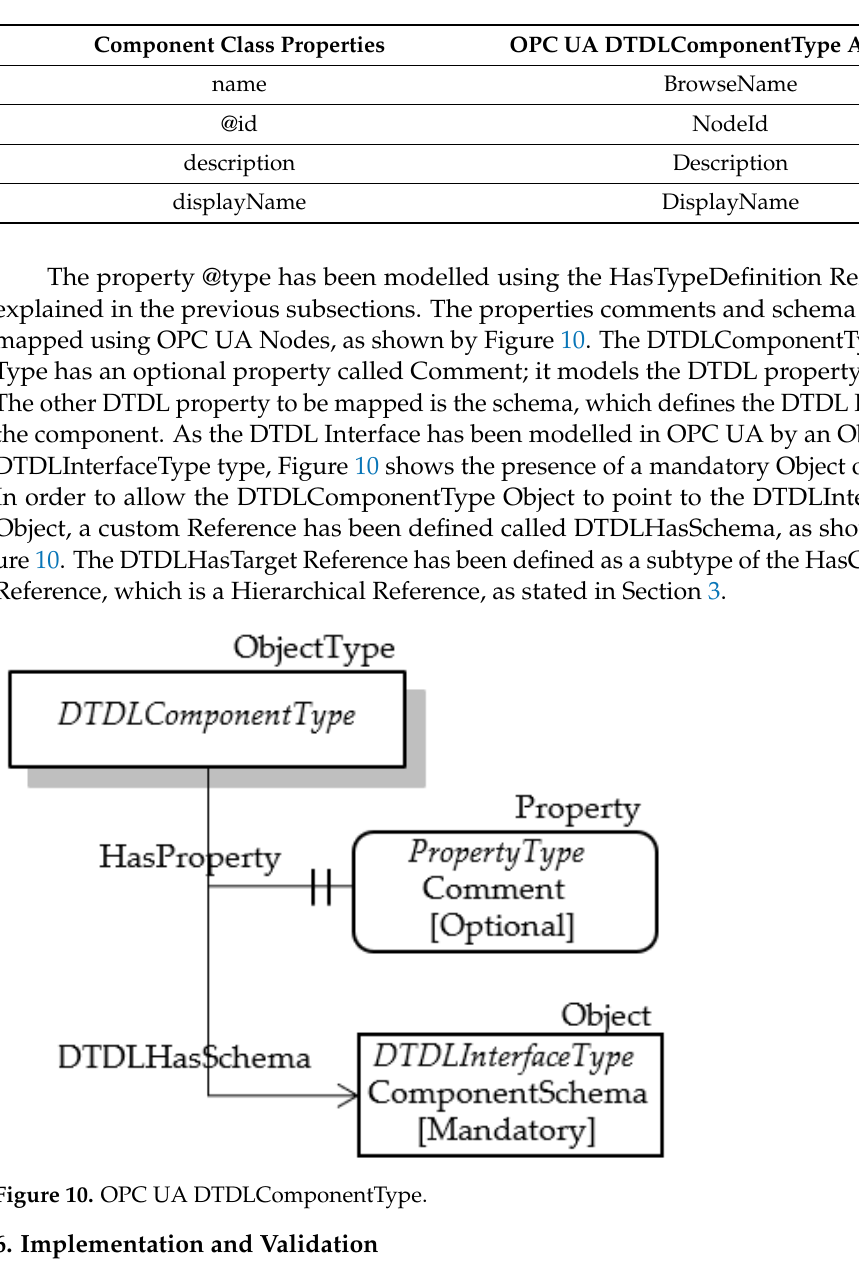
Table 14. Mapping of properties of the Component class into the OPC UA DTDLComponentType attributes.